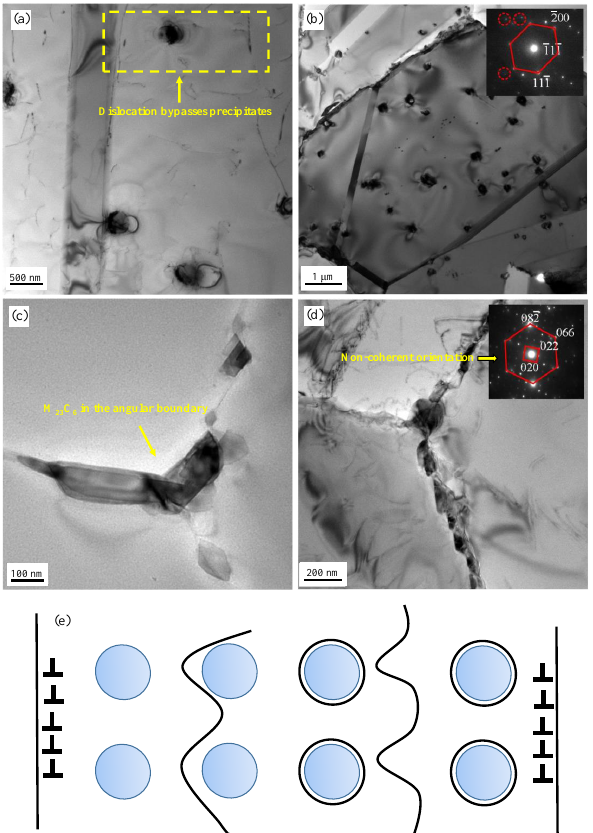
Figure 6. TEM analysis of the precipitates in specimens aged at at 750 °C for 2 h. ( a,b ) The bright field image and diffraction patterns of the coarsening (Nb, V)(C, N) particles, ( c,d ) the bright field image and diffraction patterns of M 23 C 6 in the angular boundary, ( e ) the schematic diagram of dislocation bypass the particles mechanism.